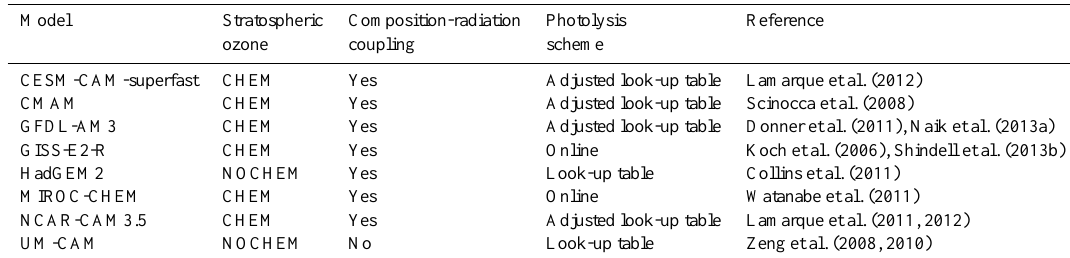
Table 1. Summary of the ACCMIP models used here.